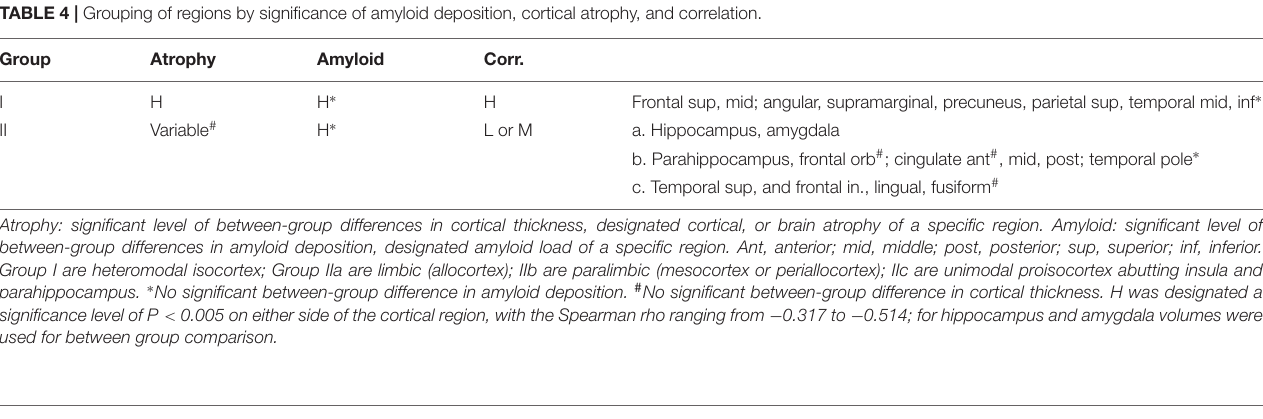
TABLE 4 | Grouping of regions by significance of amyloid deposition, cortical atrophy, and correlation. Group Atrophy Amyloid Corr.